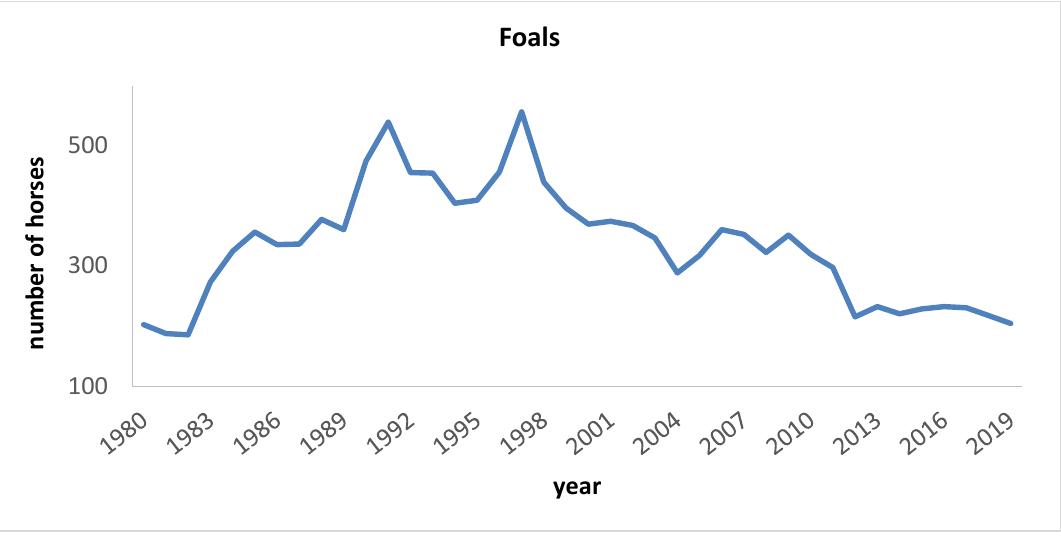
Figure 1. Number of Maremmano foals per year from 1980 to 2019.